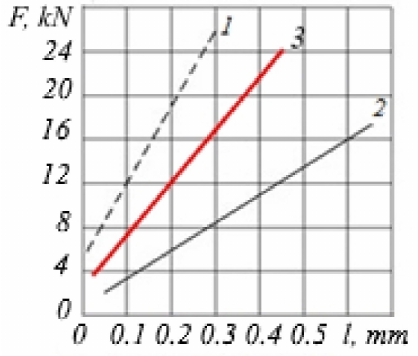
Figure 6. Dependence of tensile values on load: 1—metal rebars; 2—composite rebars, 3—composite rebars with the inclusion of micro-SiO 2 and nano-Al 2 O 3